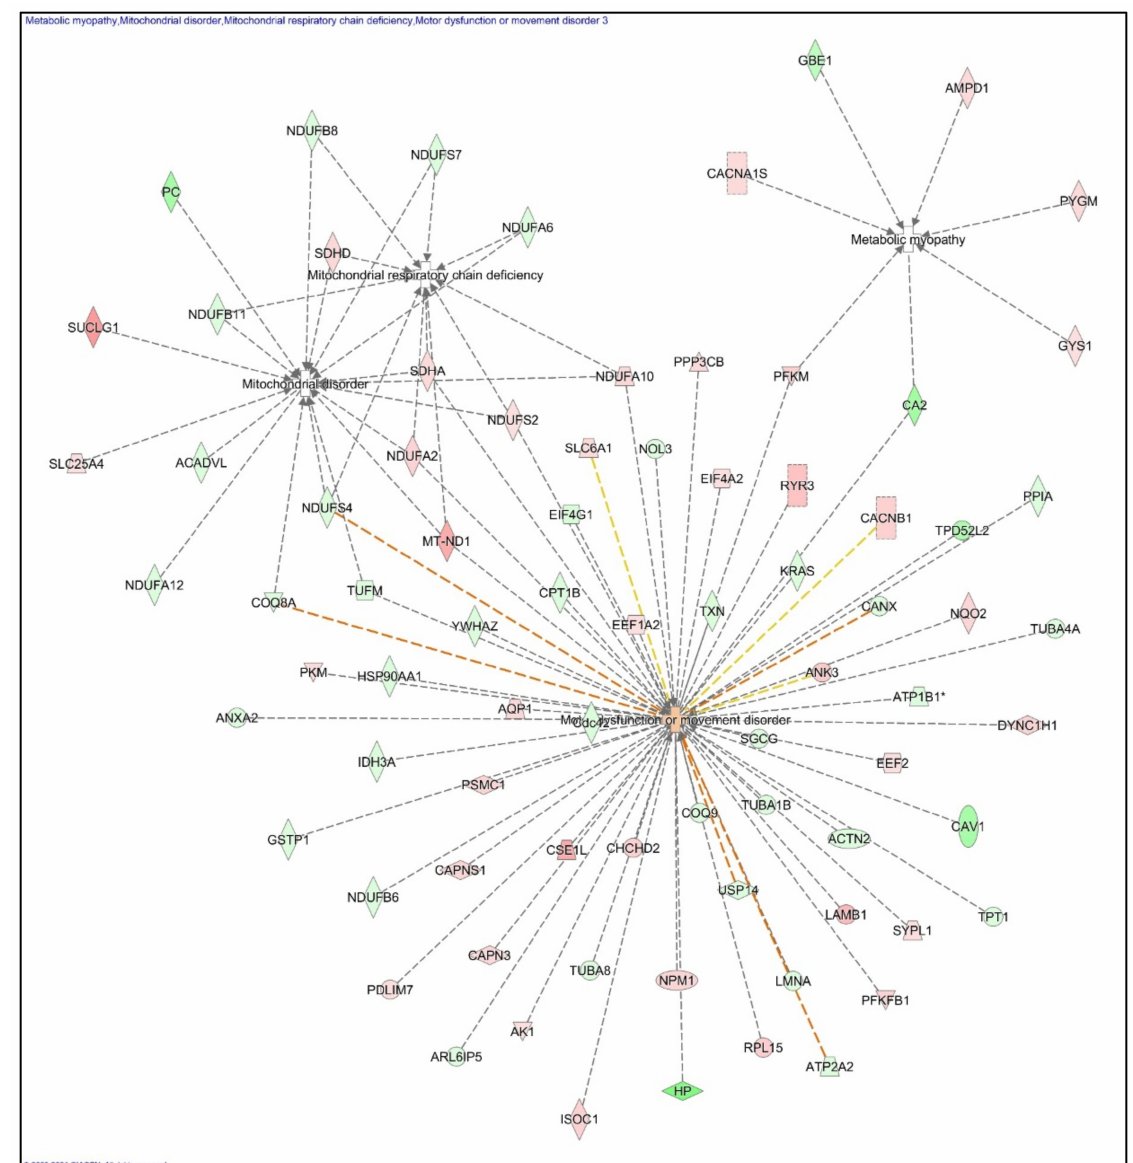
Figure 5. Graphical representation of significantly differentially expressed proteins in Nrf2-deficient skeletal muscles associated with disease and functions. The shapes represent the molecular classes of the proteins (for details visit www. qiagen.com, accessed on 21 June 2019). The color is used to indicate the direction of regulation (red, upregulated; green, downregulated), while the color shade indicates the relative magnitude of change in protein expression levels. The functional interaction networks of the proteins were generated using IPA (QIAGEN Inc., Hilden,